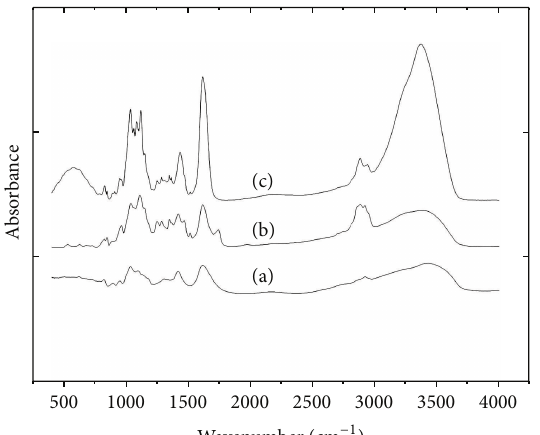
Figure 4: FT-IR spectra of (a) raw chitosan, (b) pure polyamide-6, and (c) electrospun nanofibers of polyamide-6/chitosan at 80/20 weight ratio.